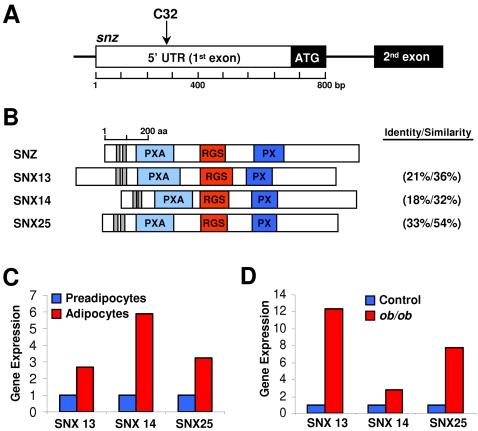

C32 Enhancer Trap P-element Inserted into the 5′UTR of snazarus.
(A) Location of the C32 P-element insertion into the first exon of the snazarus (CG1514) gene. (B) Domain structure and alignment of D. melanogaster Snz and the three mammalian homologs. Grey rectangles represent hydrophobic patches (potential transmembrane domains). (C) SNX13, SNX14 and SNX25 mRNA expression levels were quantified with real-time PCR in uninduced 3T3-L1 preadipocytes and in induced 3T3-L1 adipocytes (n = 1). (D) Fat pads were removed from control and genetically obese ob/ob mice and the levels of SNX13, SNX14 and SNX25 expression were assessed with real-time PCR (n = 1).